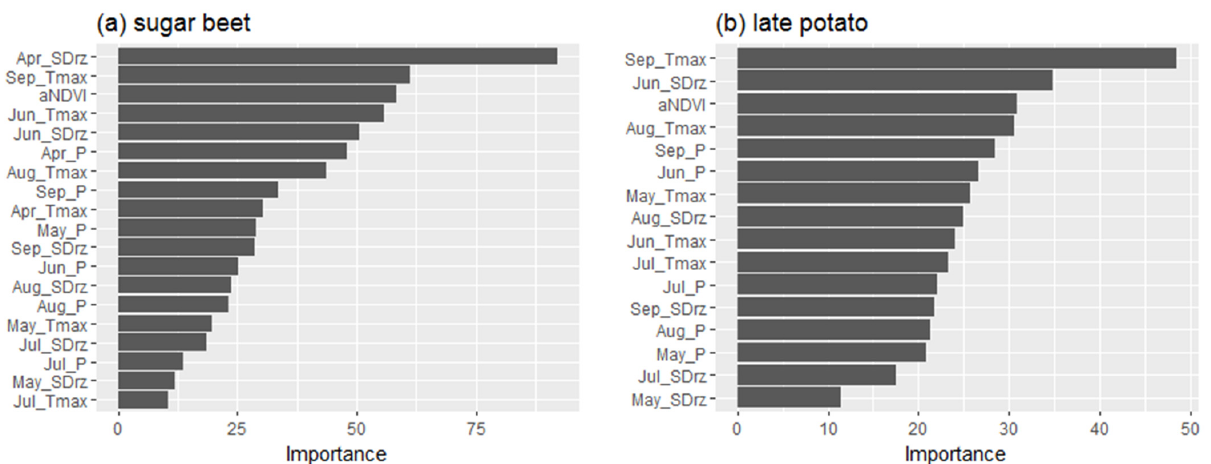
Figure 4. ( a ) Variable importance plot of Model 4 for sugar beet, ( b ) variable importance plot of Model 4 for late potato. P: precipitation, Tmax: maximum temperature, SDrz: root-zone soil water depletion.